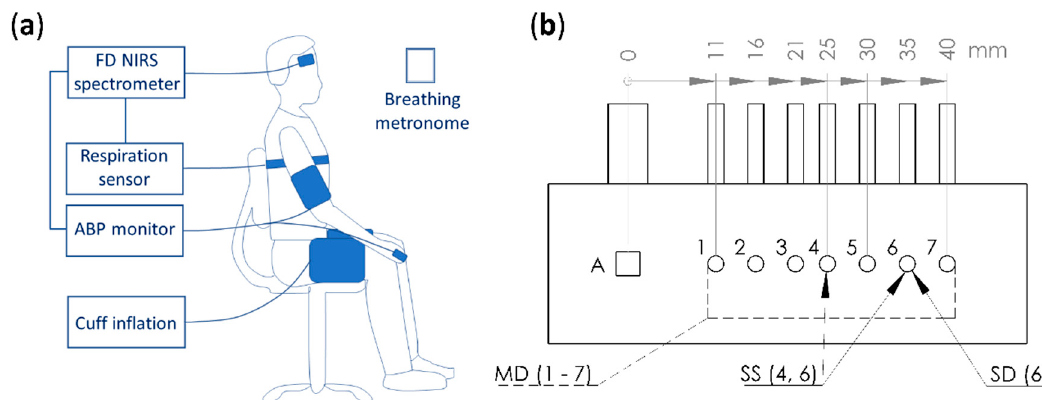
Figure 1. ( a ) Diagram of experimental setup showing seated subject with frequency-domain (FD) near-infrared spectroscopy (NIRS) probes, strain gauge respiration sensor, finger plethysmography to monitor arterial blood pressure (ABP), pneumatic thigh cuff inflations inducing ABP oscillations, and a breathing metronome used in the paced-breathing portion of the protocol. ( b ) Schematic drawing of probe geometry. Detector shown as a square and labeled A, sources shown as circles and labeled 1–7 with distances ranging from 11–40 mm. Multi-distance (MD) measurements utilized all sources to find absolute optical properties. Summary single-slope (SS) and single-distance (SD) analysis was done for all sources (paired sources spaced ~10 mm for SS, Section 3.3). Thorough analysis of SS data was done using sources 4 and 6 (25 mm and 35 mm), and thorough analysis of SD data was done using source 6 (35 mm, Section 3.4).